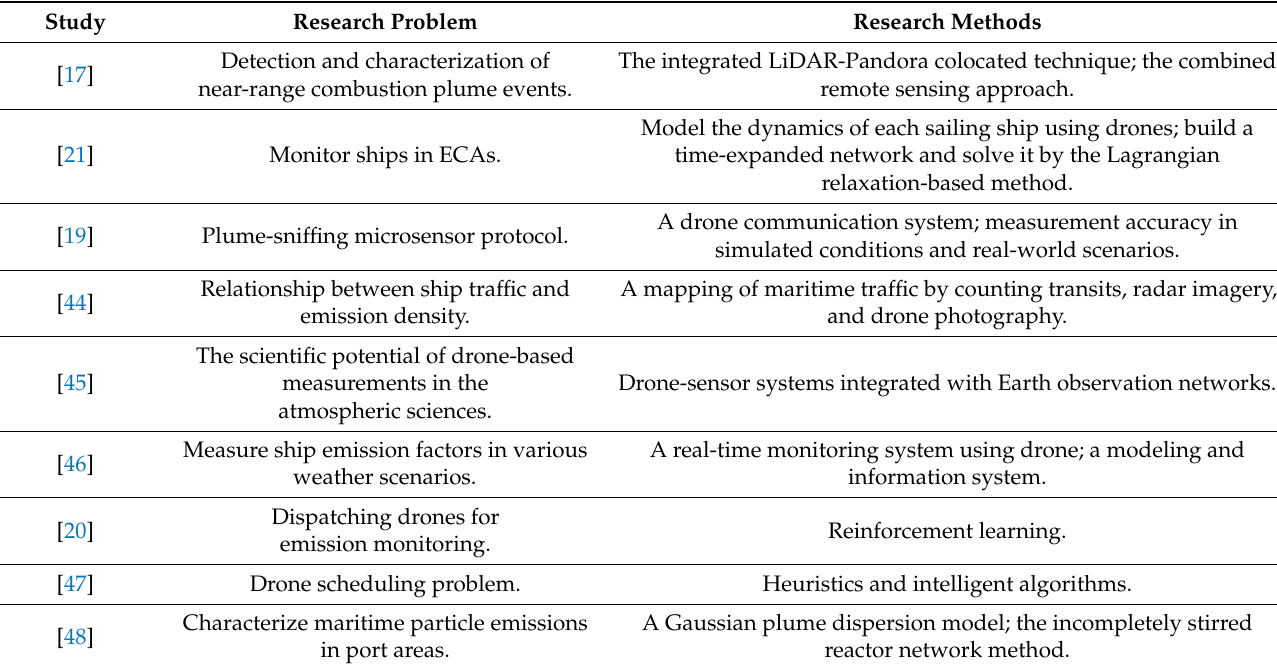
Table 2. Studies on drones applied to